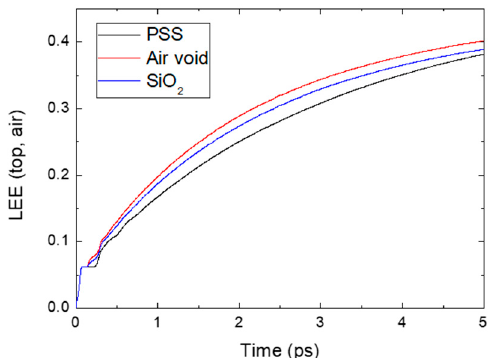
Figure A2. Light extraction efficiencies of conventional structure on PSS (PSS structure), air-void without SiO 2 nano-particles (NPs) on PSS (air-void structure), and air-void filled with SiO 2 NPs on PSS (SiO 2 structure) calculated with finite-difference time-domain (FDTD) method.